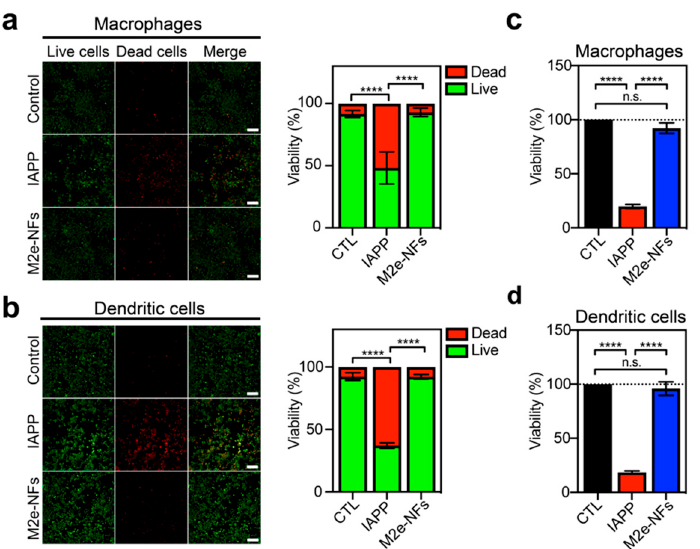
Figure 5. M2e-NFs are fully cytocompatible. ( a , b ) Qualitative and quantitative live / dead assay of M2e-NFs and amyloidogenic peptide islet amyloid polypeptide (IAPP) showing cell viability of macrophages ( a ) (J774A) and ( b ) dendritic cells (D.C2.4). Left panels are images taken by a fluorescent confocal microscope in which live cells are labelled in green (intracellular esterase activity) and dead cells are red (loss of plasma membrane integrity). Scale bar: 20 µm. ( c , d ) Cell viability evaluated from metabolic activity of ( a ) J774A and ( b ) D.C2.4 treated with M2e-NFs and IAPP. ( a – d ) Data represent the mean ± S.D. of at least three experiments performed in triplicate. Results were analyzed using the student’s t-test and statistical difference (between control cells and treated cells) was established at (****) < 0.0001.